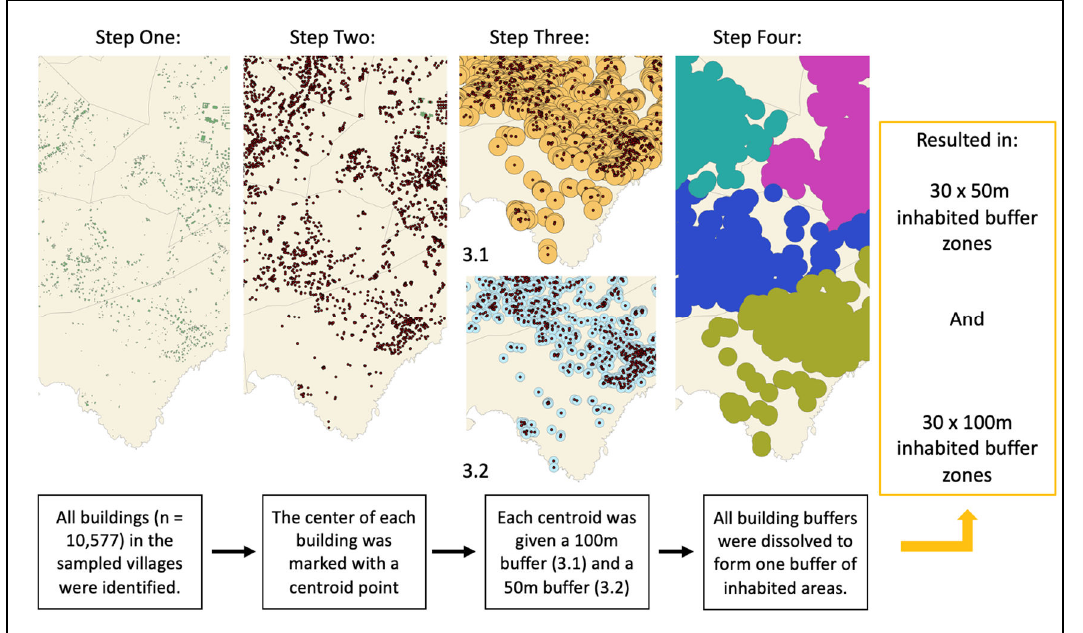
Figure 2. The process used to create the inhabited buffer zones using ArcGIS version 2.8.6 [47]. The building locations were acquired from the American Samoa National Marine Sanctuary GIS data archive [39]. Each colour in step four illustrates a different inhabited buffer zone.